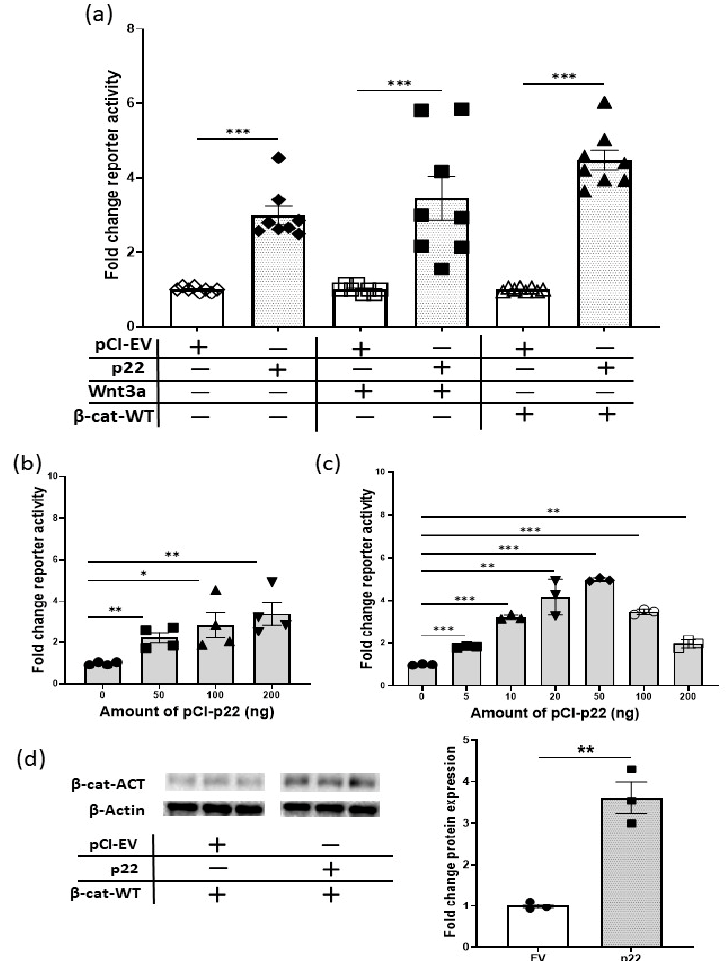
Figure 2. HBV p22 stimulates Wnt signaling in Huh7 cells. ( a ) The effect of HBV p22 alone or in addition to stimulation by Wnt 3a or wildtype β -catenin ( β -cat-WT) on TCF / β -catenin transcription in Huh7 cells, was determined by reporter activity (sTOPflash reporter) and is shown as fold change relative to empty vector(EV)(mean ± SEM,*** p < 0.0001Student t -test, n = 8independentexperiments). ( b )Huh7cellswere transfected with the indicated amounts of p22 expression plasmid. The figure shows the dose-dependent effect of HBV p22 on TCF / β -catenin transcription activity (sTOPflash reporter) (mean ± SEM, * p < 0.05, ** p < 0.001 Student t -test, n = 4 independent experiments). ( c ) Huh7 cells were transfected with the indicated amounts of p22 and 100 ng of wild-type β -catenin expression plasmids. Co-expression of 5–50 ng p22 increased TCF / β -catenin transcription activity (sTOPflash reporter) mediated by wild-type β -catenin; reporter activity decreased when 100 or 200 ng p22 was co-transfected with wild-type β -catenin (mean ± SEM, ** p < 0.001, *** p < 0.0001 Student t -test, n = 3 independent experiments). ( d ) Immunoblot analysis for the transcriptionally active form of β -catenin ( β -cat-ACT) on lysates prepared from Huh7 cells co-transfected with 100 ng wild-type β -catenin, 100 ng of p22 or equivalent EV expression plasmids. The membrane was stripped and re-probed with anti-actin antibody. The bar graph shows quantitative analysis for the levels of detected active β -catenin using Image Lab software and normalized for β -actin levels (mean ± SEM, ** p < 0.001 Student t -test, n = 3